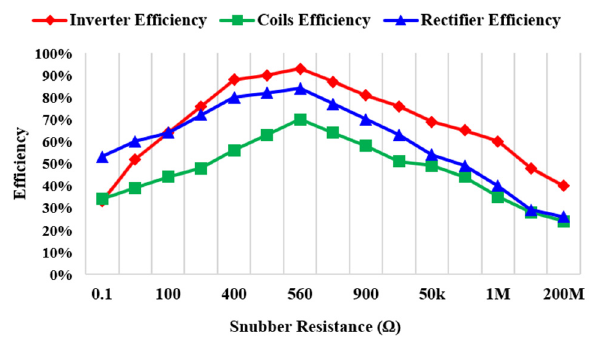
Figure 6. Checking the maximum efficiency of different elements in the WPT system to verify the optimized snubber resistance.